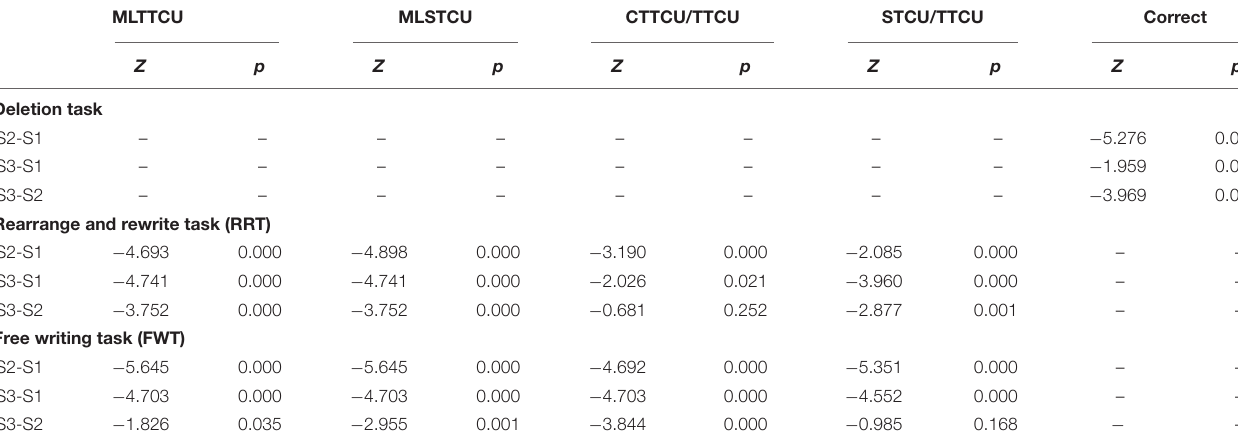
TABLE 5 | Z and p values of Wilcoxon signed-rank tests of the training group on all tasks in the written assignments. MLTTCU MLSTCU CTTCU/TTCU STCU/TTCU